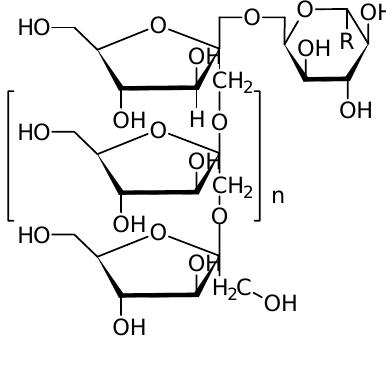
Figure 3. Chemical structure of